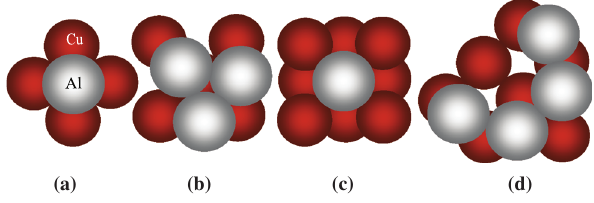
Figure 7: Contact manners between liquid Al atoms and surface atoms of solid Cu (a) Four Cu atoms around an Al atom (b) Three Al atoms around a Cu atom (c) Eight Cu atoms around an Al atom (d) Two Al atoms around a Cu atom.